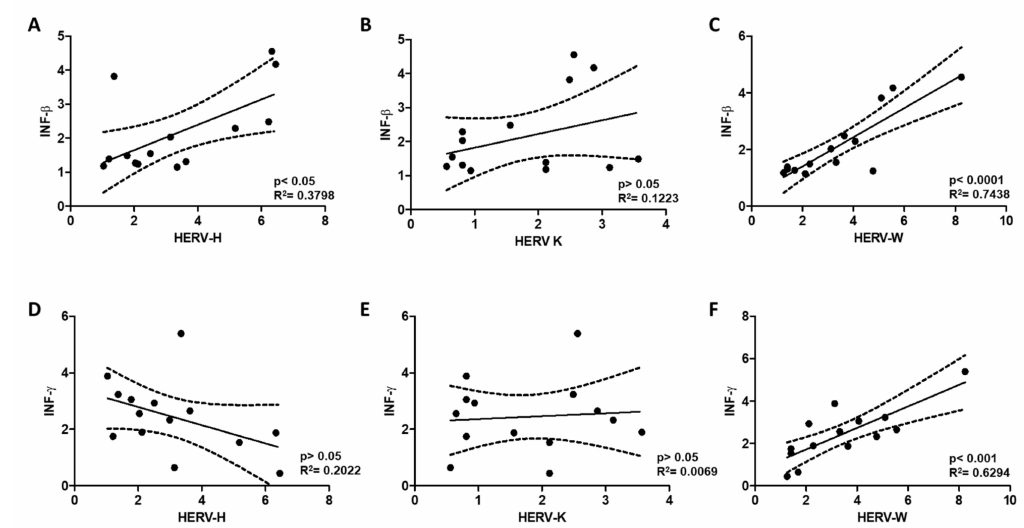
Figure 3. Linear regression analysis of HERV-H, HERV-K and HERV-W levels with respect to INF- β ( A – C ) and INF- γ ( D – F ) levels in PBMCs of FM patients. Adjusted calculated best-fit lines together with SD values (dotted lines) are represented for each data set pair; R 2 and p values are indicated. Positive significant correlations were also detected between HERV-H and HERV-W levels (Figure 4). Other combinations tested did not show statistical significance (Figures 3 and 4).